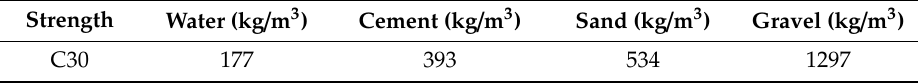
Figure 6. Concrete block dimensions (mm).